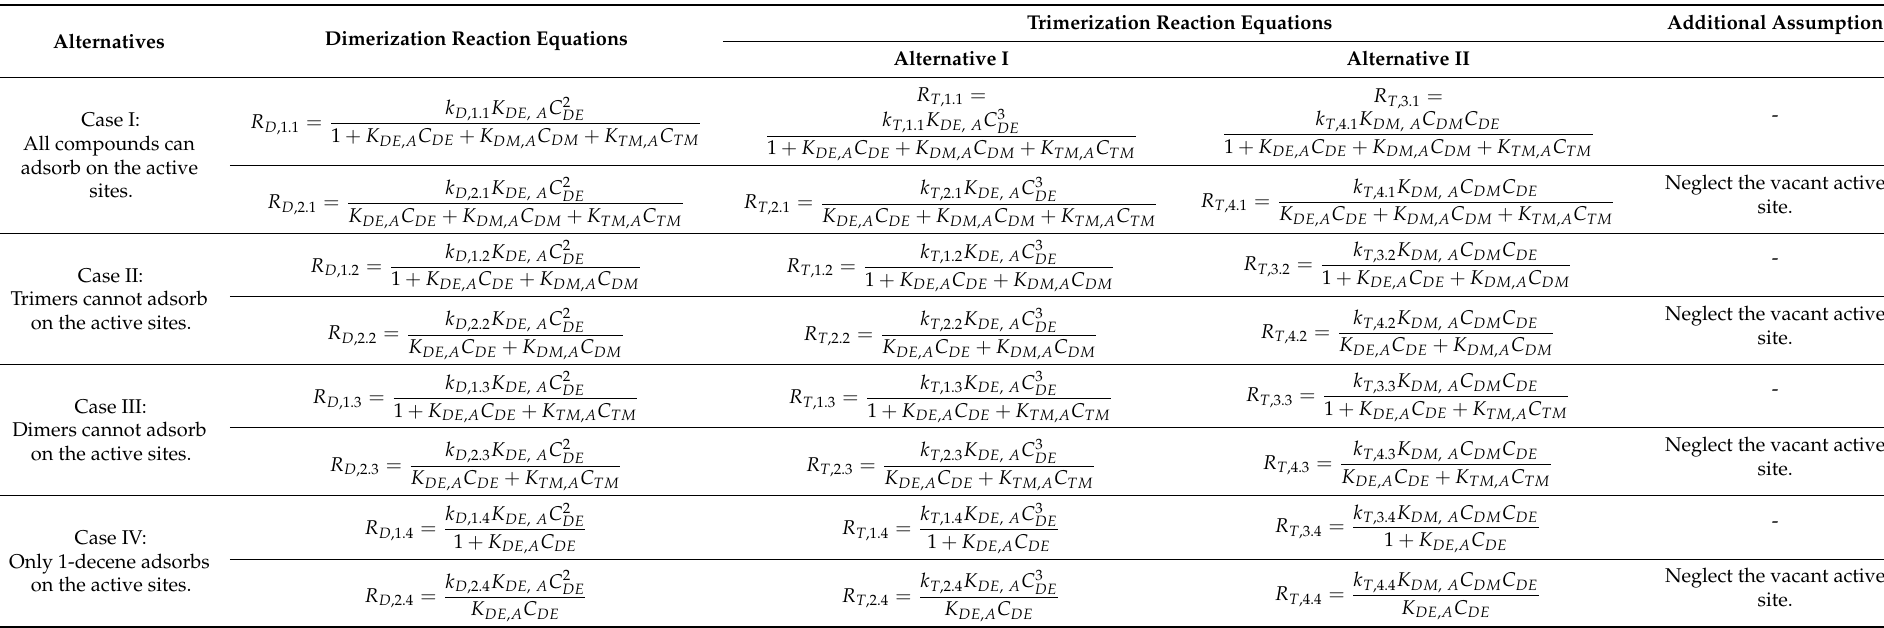
Table 3. All proposed reaction rate equations for the dimerization and trimerization reactions from 1-decene over the HY zeolite catalyst under microwave irradiation.